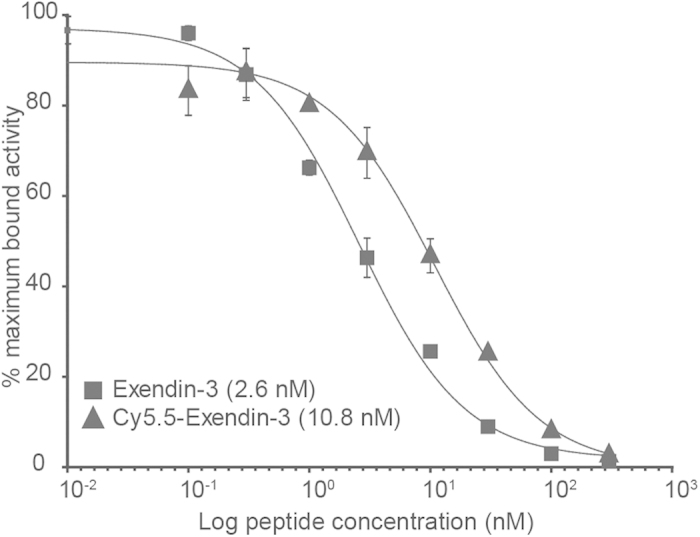
Competition binding assay (IC50) of exendin-3 and Cy5.5-exendin-3 on CHL-GLP1R cells.111In-DTPA-exendin-3 was used as tracer. The sample with the highest binding percentage was set at 100%.